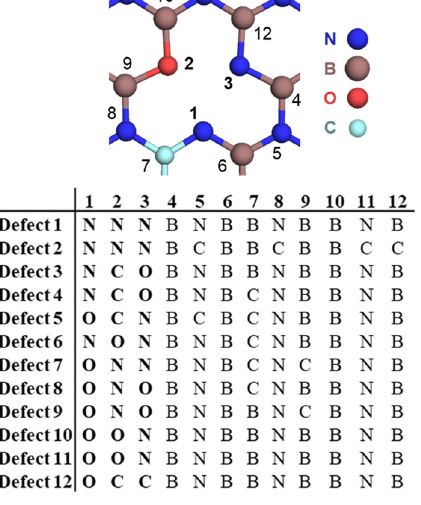
Fig. 5 Atomic compositions of V B monovacancies. A nomenclature is introduced to label the heteroatom substitutions, which enumerates an edge of the innermost three N atoms clockwise as 1 to 3 highlighted in bold type, and the remaining B and N atoms as 4 to